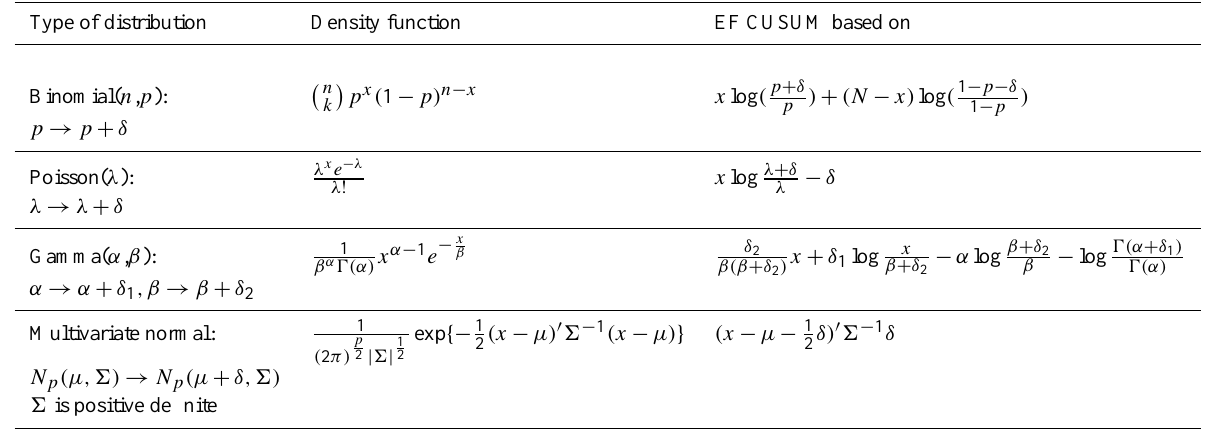
Table 1. Exponential family CUSUM: binomial, exponential, gamma and multivariate normal distributions. Type of distribution Density function EF CUSUM based on Binomial( n , p ):